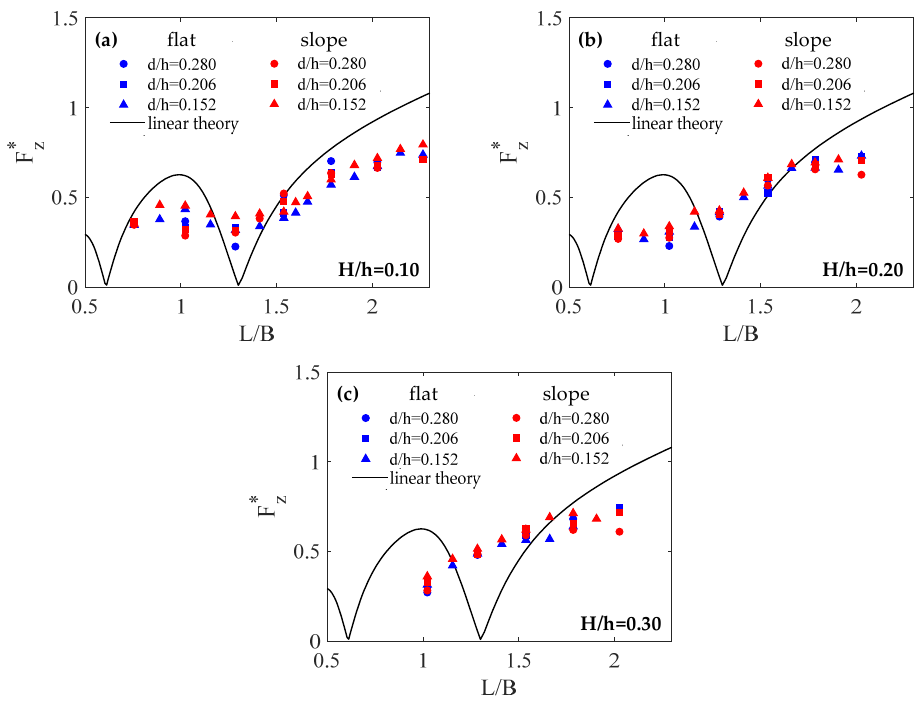
Figure 8. The vertical wave forces due to regular waves in terms of the different relative wave heights ( a ) H/h = 0.10, ( b ) H/h = 0.20 and ( c ) H/h = 0.30.